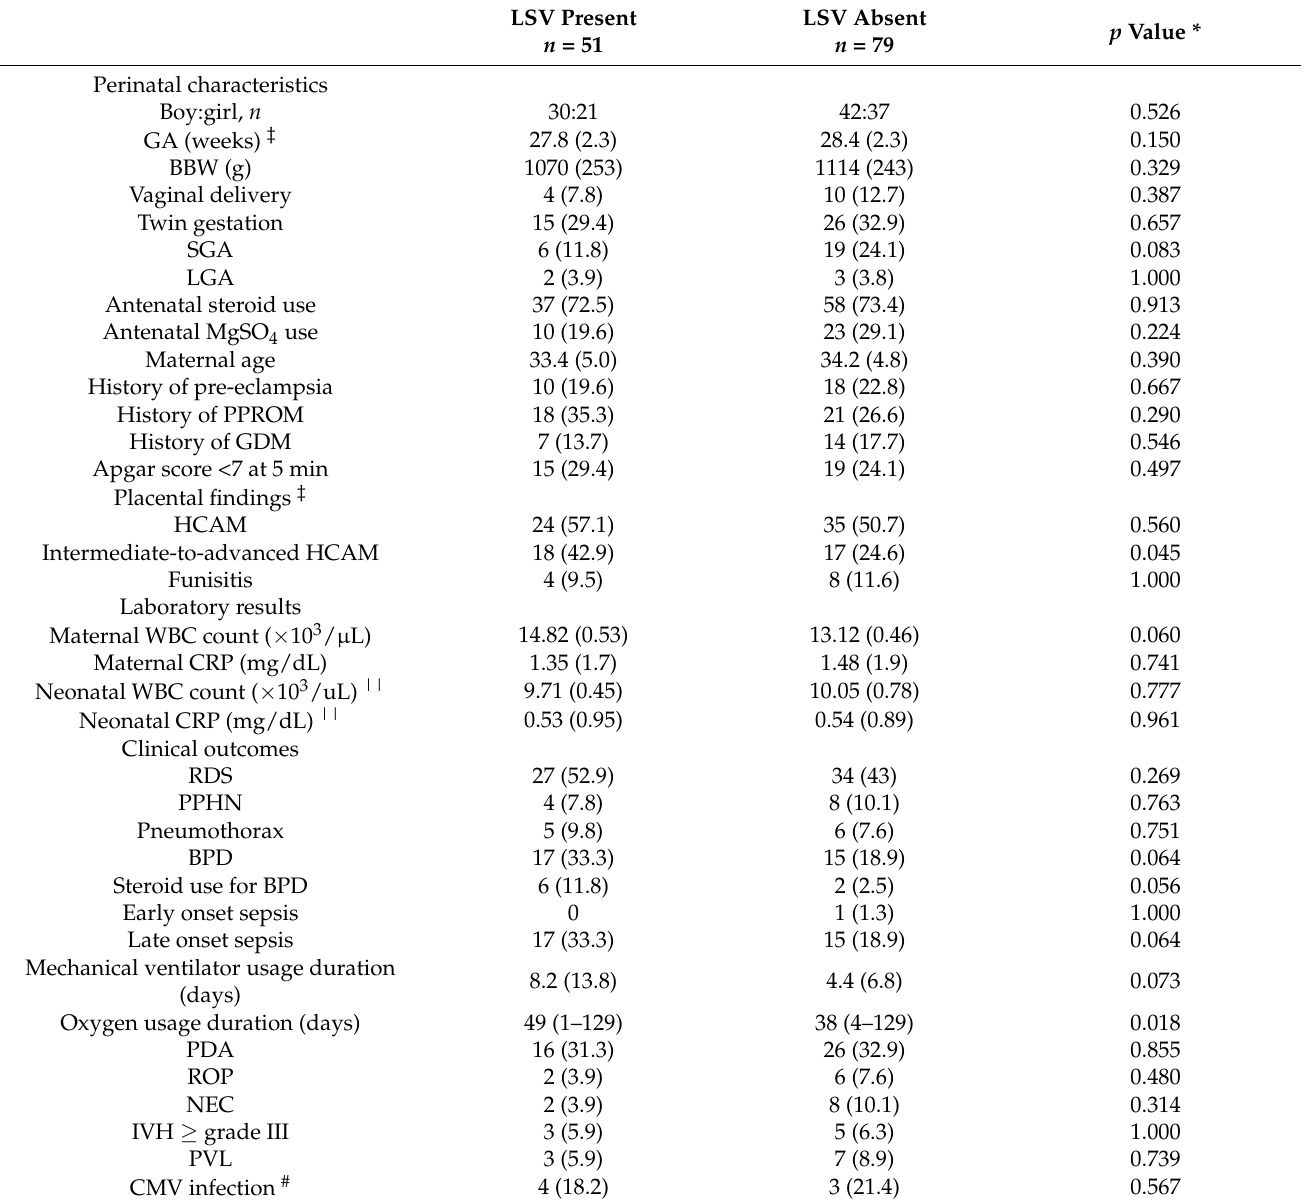
(Table 3). A total of 22 of 51 neonates with LSV underwent CMV evaluations, and four (18.2%) had CMV infections. A total of 14 of 79 neonates without LSV underwent CMV evaluations, and three (21.4%) had CMV infections. Table 2. Perinatal characteristics of preterm infants with and without lenticulostriate